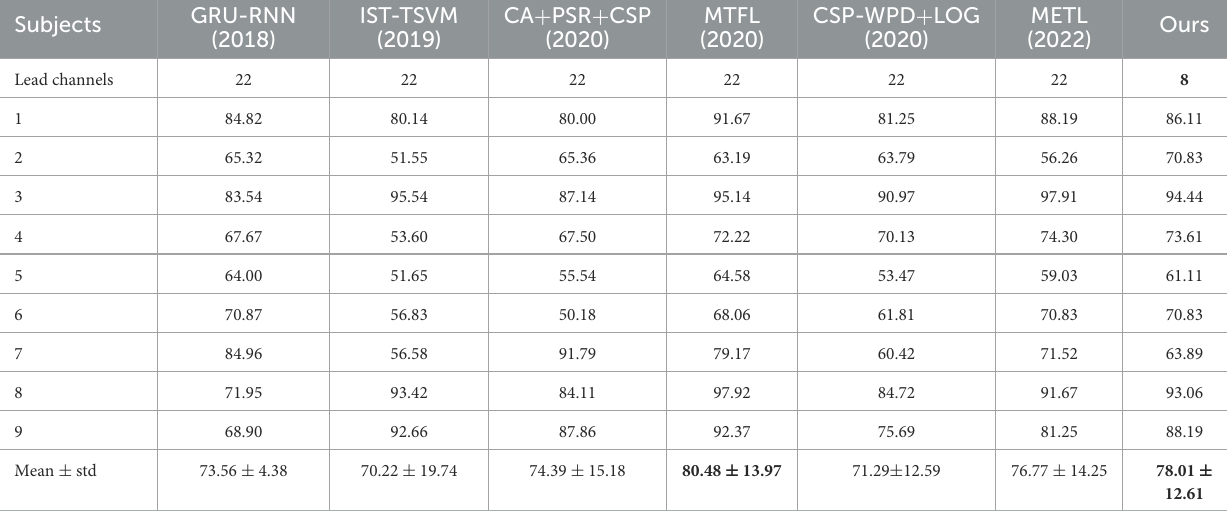
TABLE 4 Classification accuracy of the proposed method and other new methods on Dataset 1.